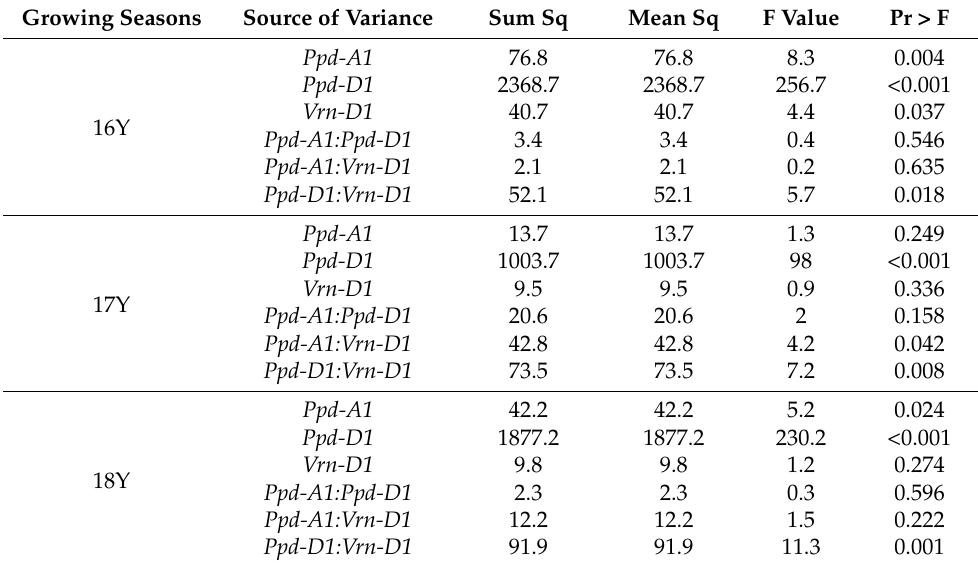
Table 2. Variance analysis of the effects of photoperiod alleles, vernalization alleles, and their interactions on the anthesis of 100 wheat varieties evaluated in three growing seasons